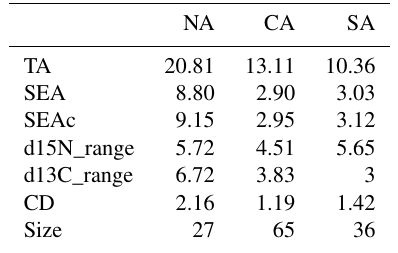
Table 3. Estimates of the convex hull (TA); standard ellipse area (SEA and SEAc, as corrected for low sample size); and Layman metrics d15N_range, d13C_range, and mean distance to centroid (CD), calculated for zooplanktonic communities from the three sub-areas. NA: northern Adriatic, CA: central Adriatic, SA: southern Adriatic. Sample size is also